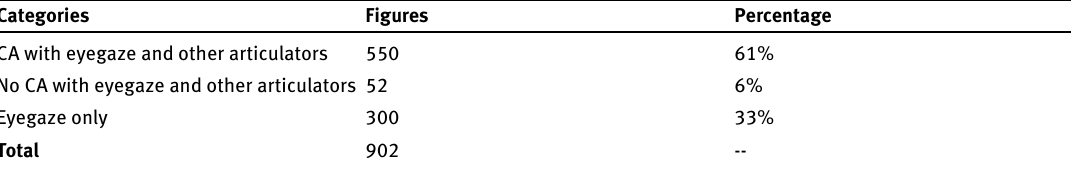
Table 4. Constructed action/eyegaze categories coded for tokens with evidence of eyegaze shift towards